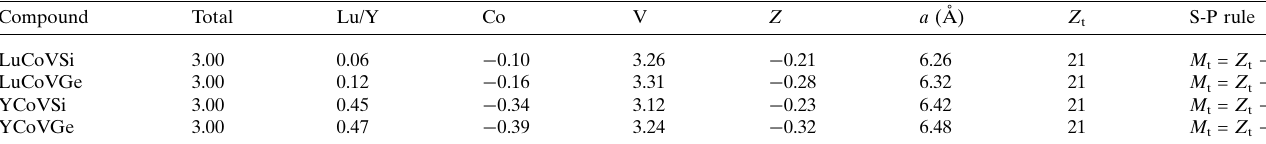
Table 2 Total and individual atomic magnetic moments ( (cid:2) B ), calculated equilibrium lattice constant, number of valence electrons, and possible Slater–Pauling (S-P) rule for the EQH compounds M CoV Z ( M = Lu, Y; Z = Si, Ge) with type III structure.